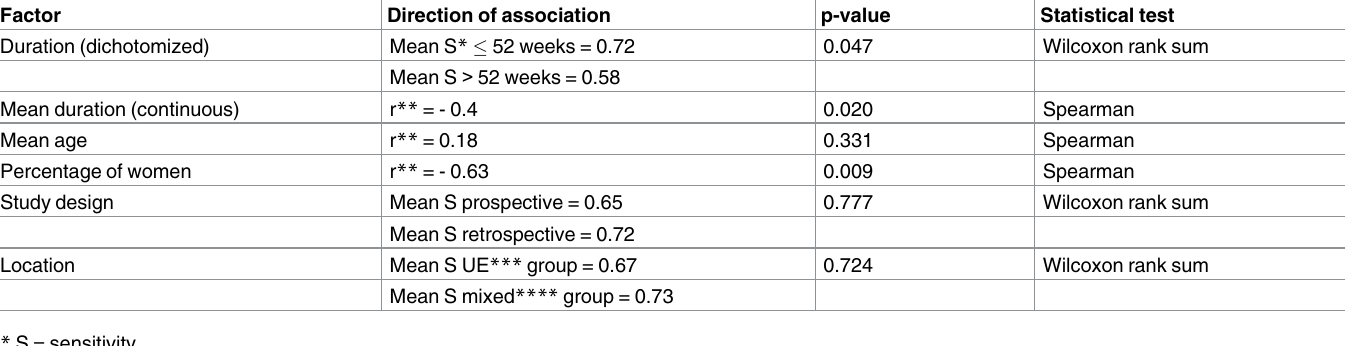
Table 3. Factors associated with positive bone